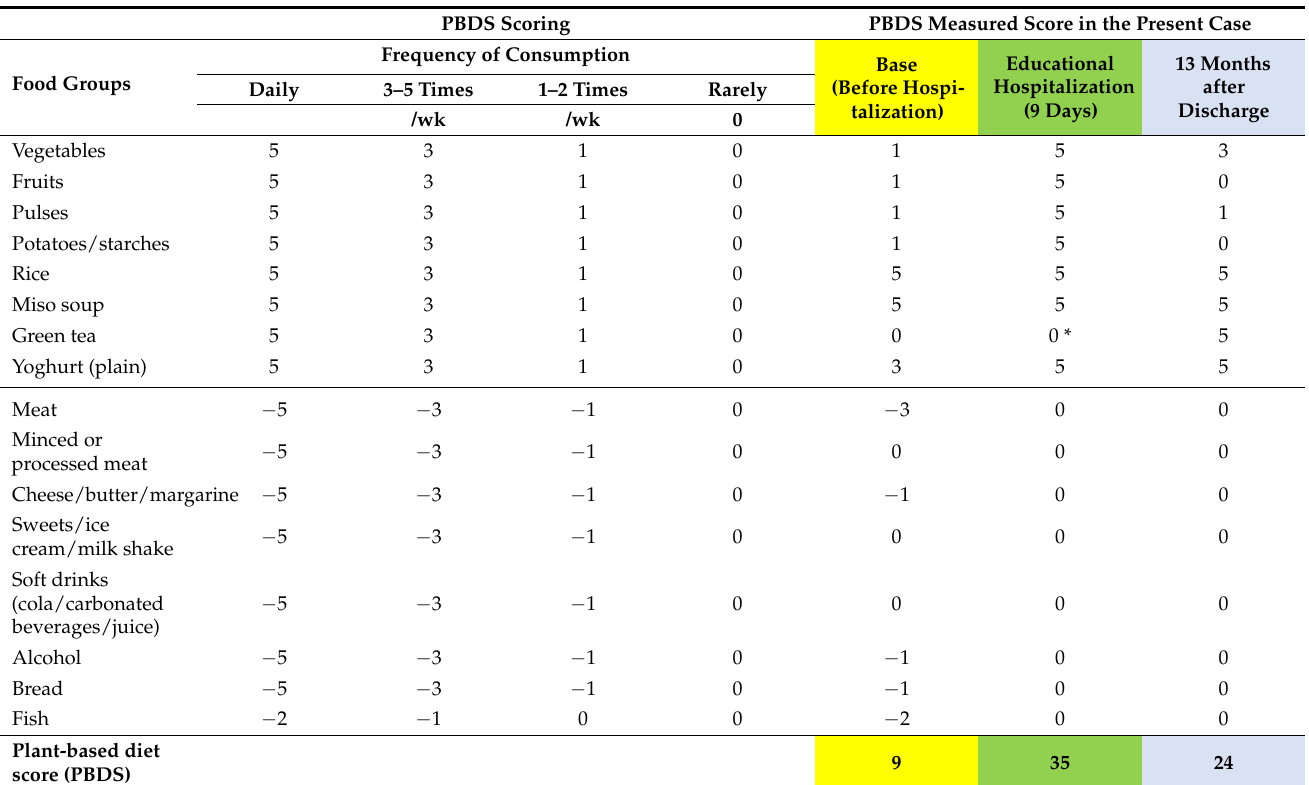
Table 1. Chronological change of plant-based diet score (PBDS). PBDS